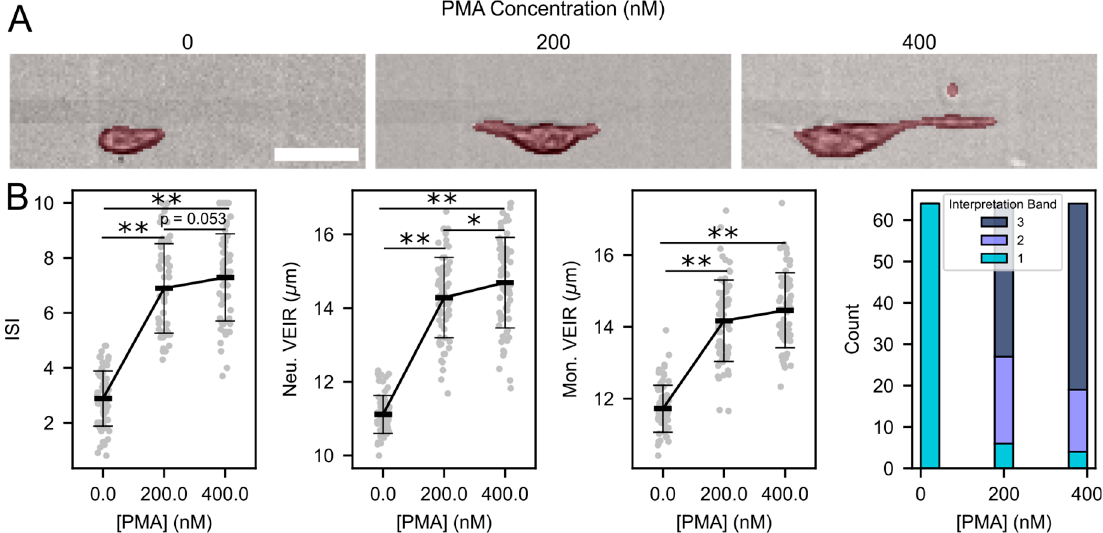
Figure 2. Effect of phorbol myristate acetate (PMA) on neutrophil deformability and IntelliSep measurements. Whole blood was incubated with PMA for 10 min then run through the IntelliSep test. ( A ) Representative images of neutrophils passing through microfluidic junction of the IntelliSep test. Neutrophils are pseudo-colored in maroon. Representative images were selected by identifying runs that yielded average IntelliSep Index (ISI) values for a given concentration and selecting neutrophil cell events that yielded average viscoelastic inertial response (VEIR) measurements for that run. Greater deformation of neutrophils was observed at increasing PMA concentration. Scale bar = 50 µm. ( B ) Aggregated data for IntelliSep measurements at varying PMA concentrations. Data sampling consisted of 18 donors and 3 repeats per donor per concentration of PMA. ISI and VEIR measurements were corrected for donor-to-donor variation by dividing by the donor average at 400 nM PMA concentration then rescaling the values to their original measurement range. We observed increases in ISI, cell oscillations (VEIR), and number of samples in Band 3 interpretation band with increasing PMA concentration. (* and ** denote p < 0.05 and p < 10 − 10 respectively; p -values computed with analysis of variance (ANOVA) and Tukey Honestly Signi fi cant Di ff erence (HSD) post-hoc test).